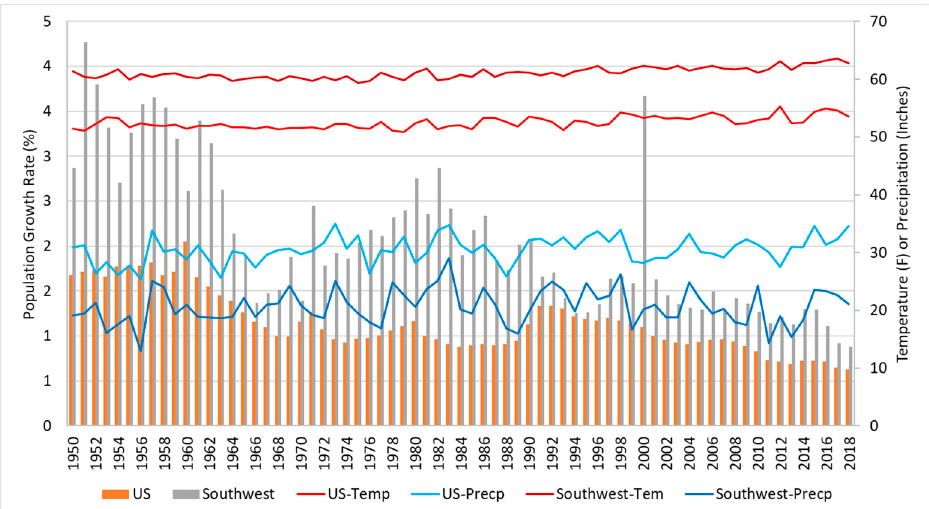
Figure 1. Changes in population over time, average annual temperature, and total precipitation in the US and southwestern states (Arizona, California, and Texas) (1950–2018). Source: Authors calculations, US Census Bureau for the population estimates, and National Oceanic and Atmospheric Administration (NOAA) National Centers for Environmental Information for temperature and precipitation [13]. Notes: Population growth indicates annual population changes in the US and average annual population changes in the three states included in this review. Temperature and total annual precipitation indicate the average annual statistics for the US and the three states.